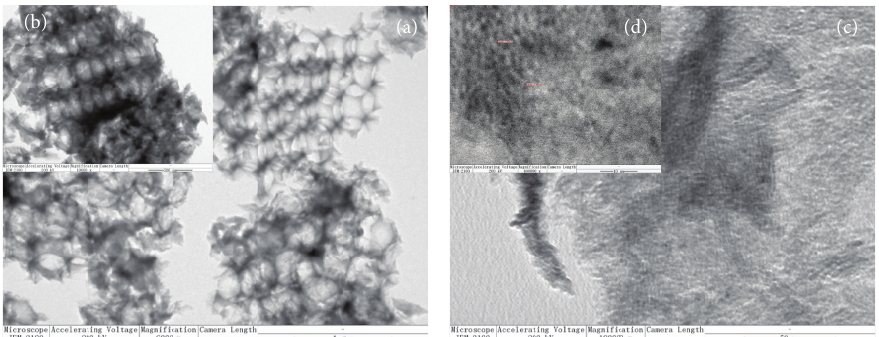
Figure 3: TEM images of 𝛼 -FeOOH